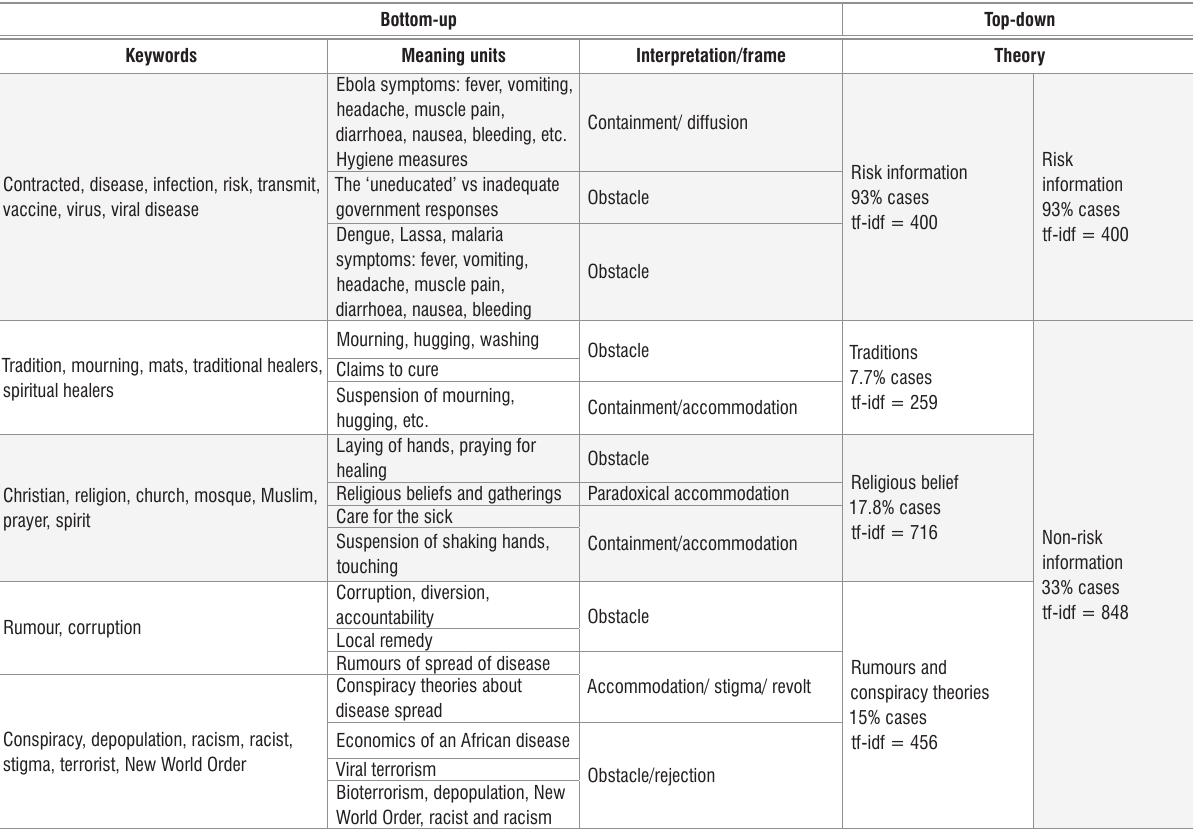
tf-idf, term frequency-inverse document frequency See supplementary material for more